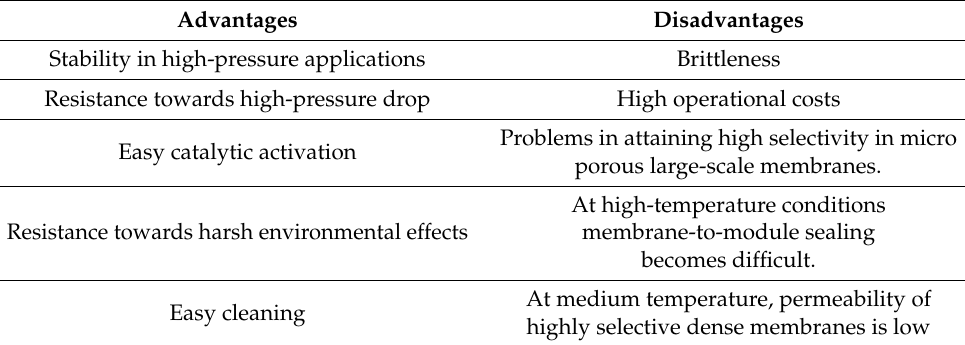
Table 4. Advantages and disadvantages of inorganic membranes [84]. Advantages